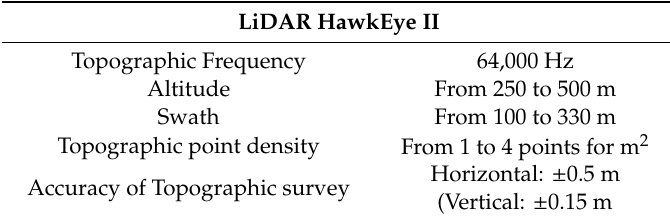
Table 1. Main technical features of topographic LiDAR sensor.